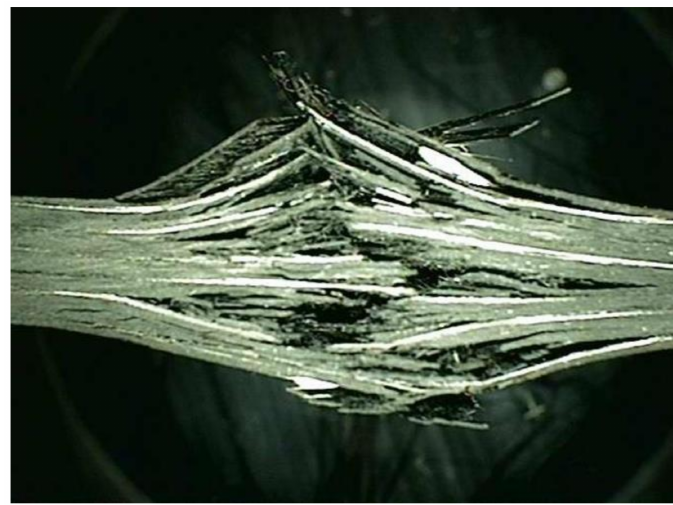
Figure 4. Investigation of the fracture surface of the compression specimen.